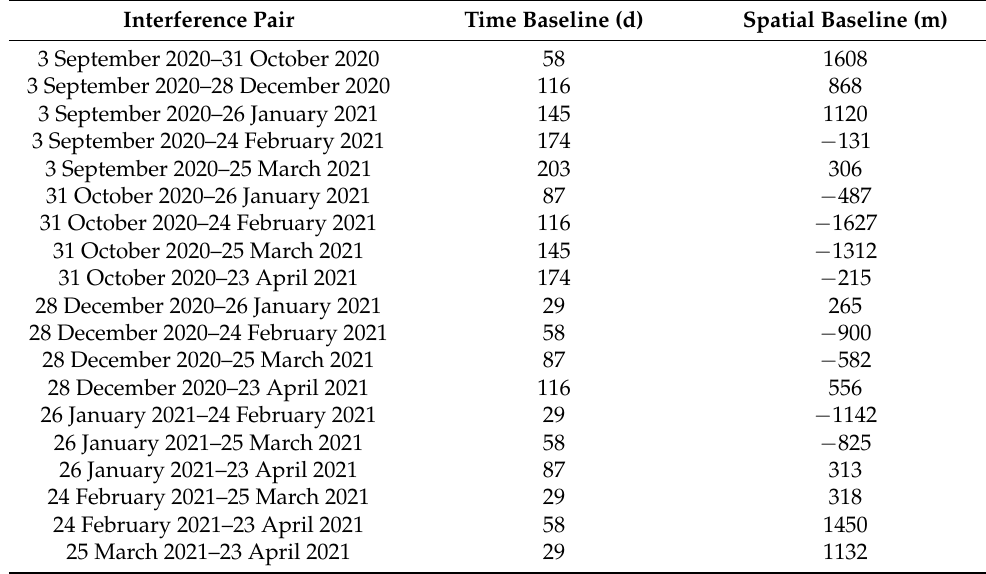
Table 3. Baseline information of Gaofen-3’s interferometric pairs. Interference Pair